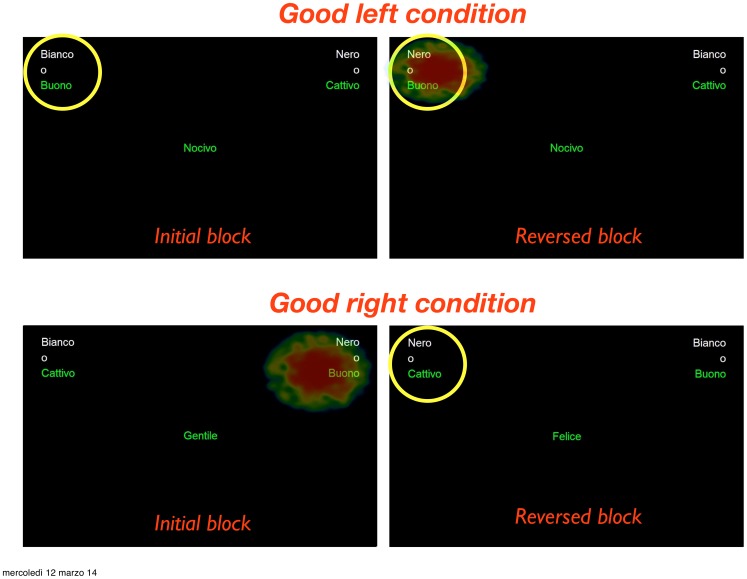
The screenshots show the 2×2×2 combination of the ethnic category “nero” (black) and “bianco” (white) with the qualitative attributes “buono” (good) and “cattivo” (bad) for both good left and good right conditions.For each experimental condition, a yellow circle represents the effect of position on fixation number whereas the heat map represents the effect of category-attribute combination on fixation duration.